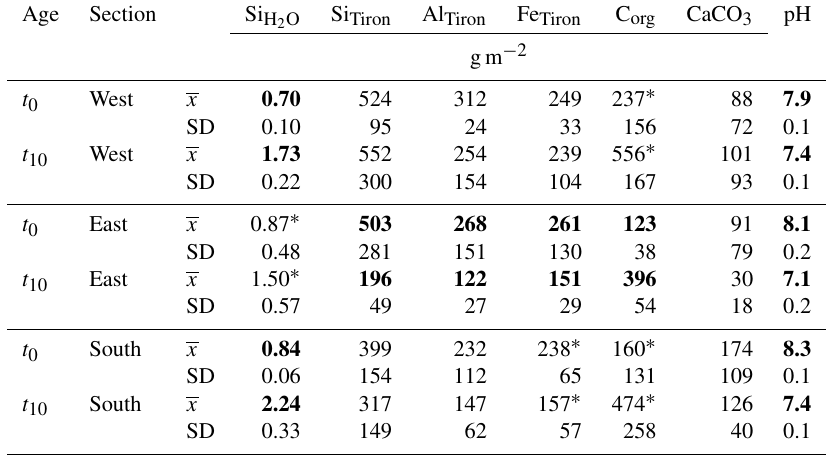
Table 2. Measured soil parameters (upper 5cm, means ( x ) with standard deviation – SD) at the different sections of Chicken Creek. Age Section Si H Si Tiron Al Tiron Fe Tiron 2 O